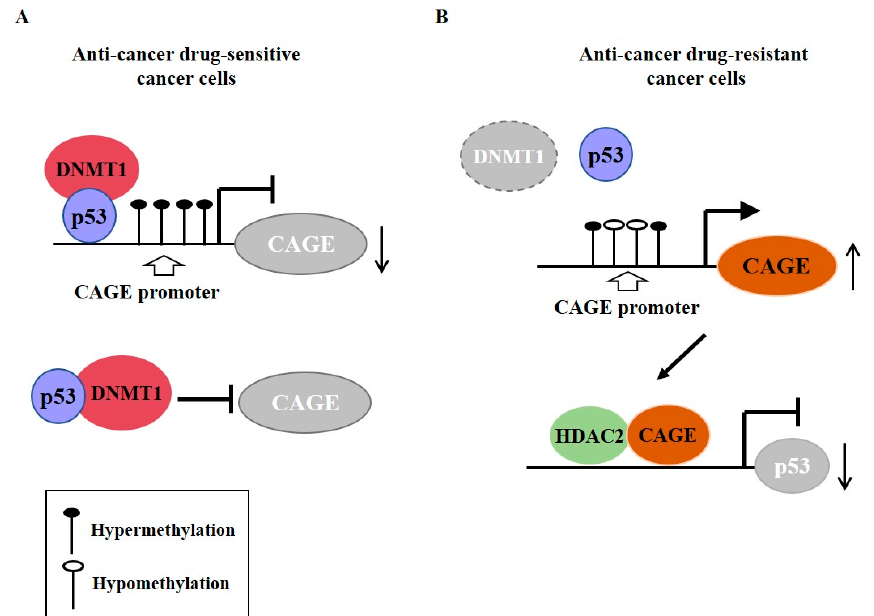
Figure 5. Cancer-associated genes (CAGE) confers resistance to anti-cancer drug resistance. ( A ) In anti-cancer drug-sensitive cancer cells, DNMT1 (DNA methyl transferase I) binds to p53. DNMT causes hypermethylation of promoter sequences of CAGE. In anti-cancer drug-resistant cancer cells, expression of DNMT1 is decreased. This results in hypomethylation of CAGE and increased expression of CAGE. CAGE can bind to HDAC2. The CAGE-HDAC2 complex can bind to the promoter sequences of p53 and decrease expression of p53. The T-bar arrows denote inhibition of transcription / negative regulation and → arrows denote activation of transcription. The ↑ arrows denotes increased expression level and ↓ arrows denotes decreased expression level.